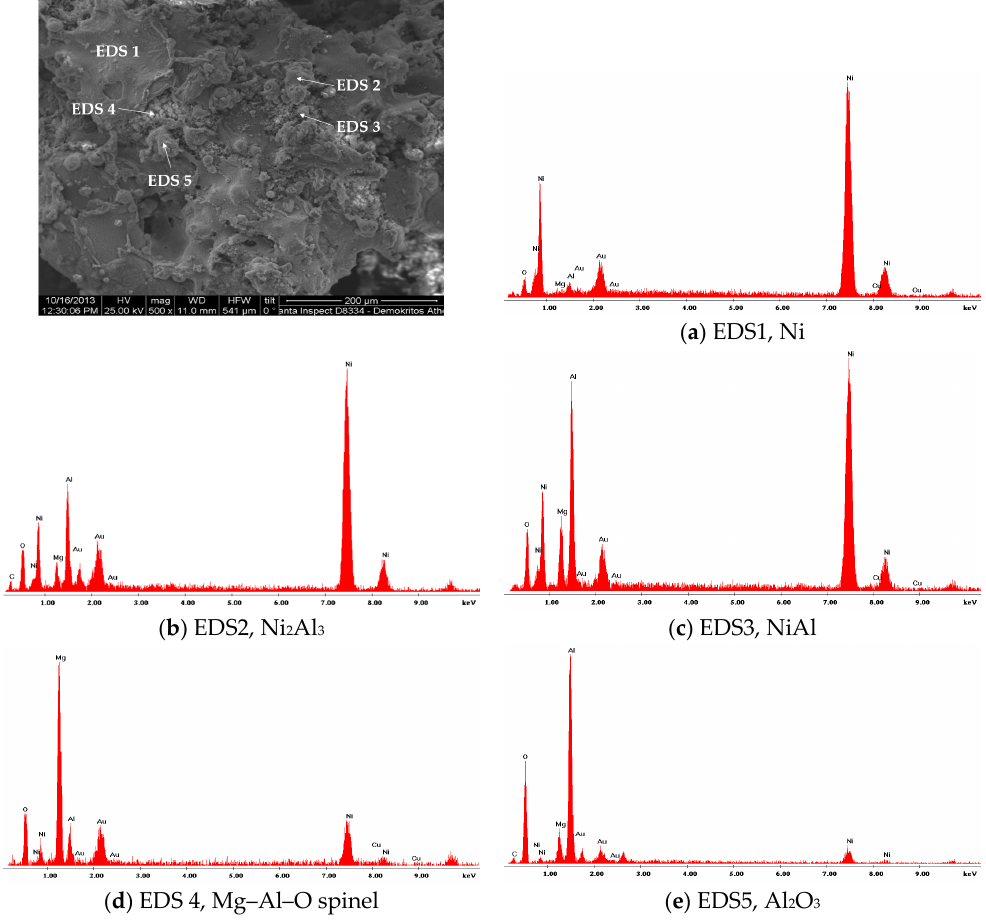
Figure 4. Scanning electron microscopy (SEM)/energy-dispersive X-ray spectroscopy (EDX) analysis of catalytically active coatings Sp-Ni65-2 (initial powder mixture of 65.1% Ni + 34.9% Al with two gun passes on MgAl 2 O 4 substrate. The catalytic coating contains about 13.9% nickel aluminide). ( a ) EDS 1; ( b ) EDS 2; ( c ) EDS 3; ( d ) EDS 4; ( e ) EDS